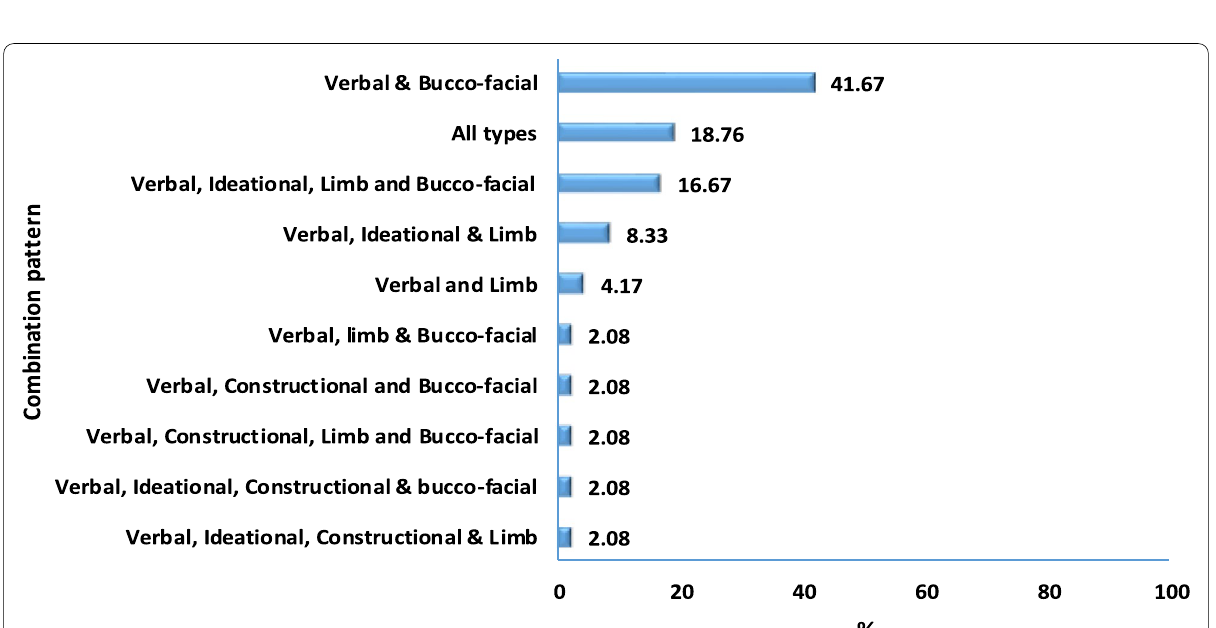
Fig. 2 Demonstration of combined types of apraxia among cases. The most frequent combination was of verbal apraxia and buccofacial apraxia which constitutes